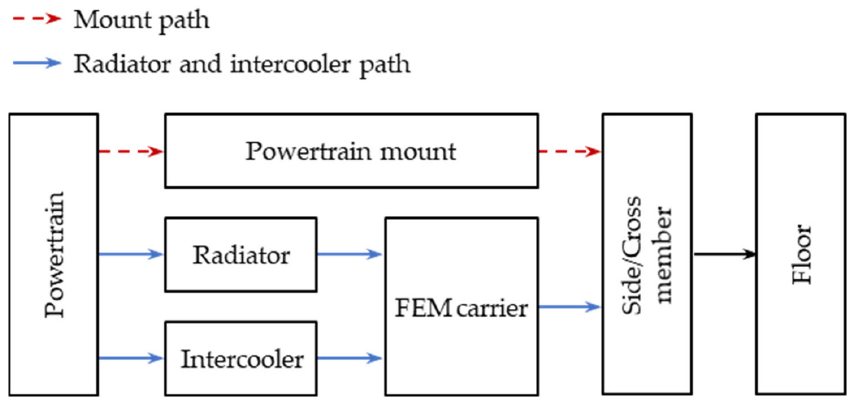
Figure 2. Transmission paths of idle vibration for the diesel SUV.